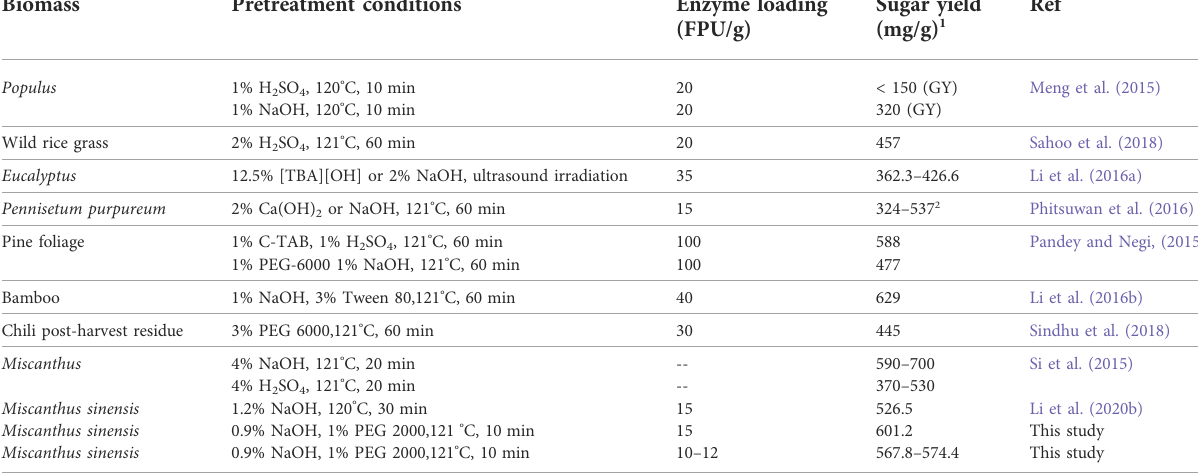
TABLE 1 Comparison of the fermentable sugar recovery from different